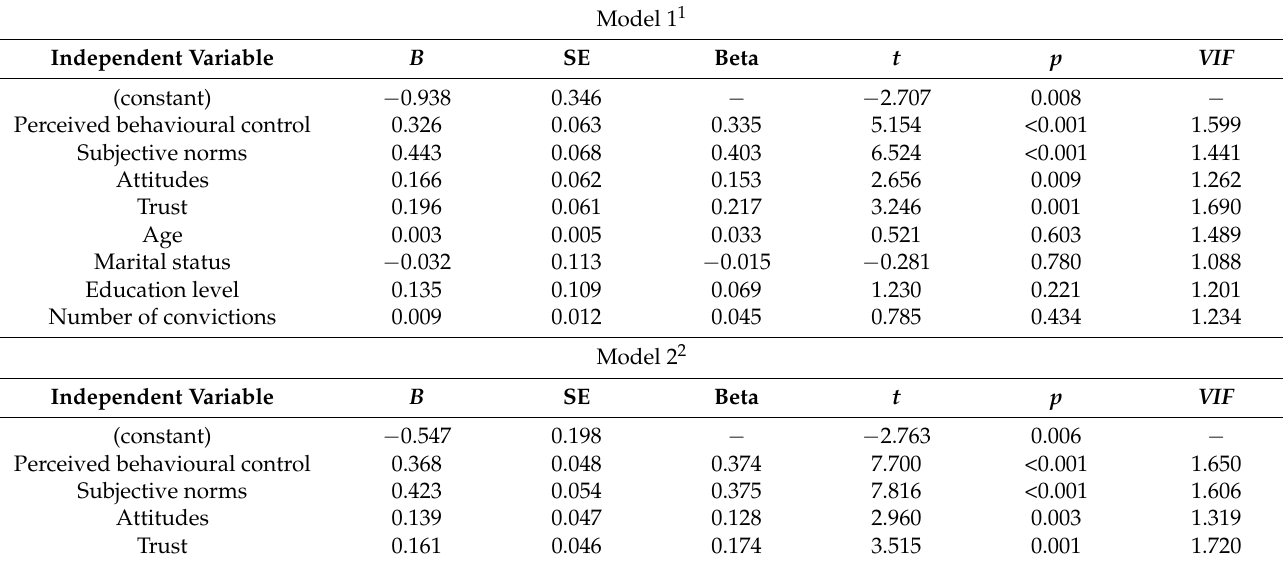
Table 4. Linear regression analysis (dependent variable: intention to use digital